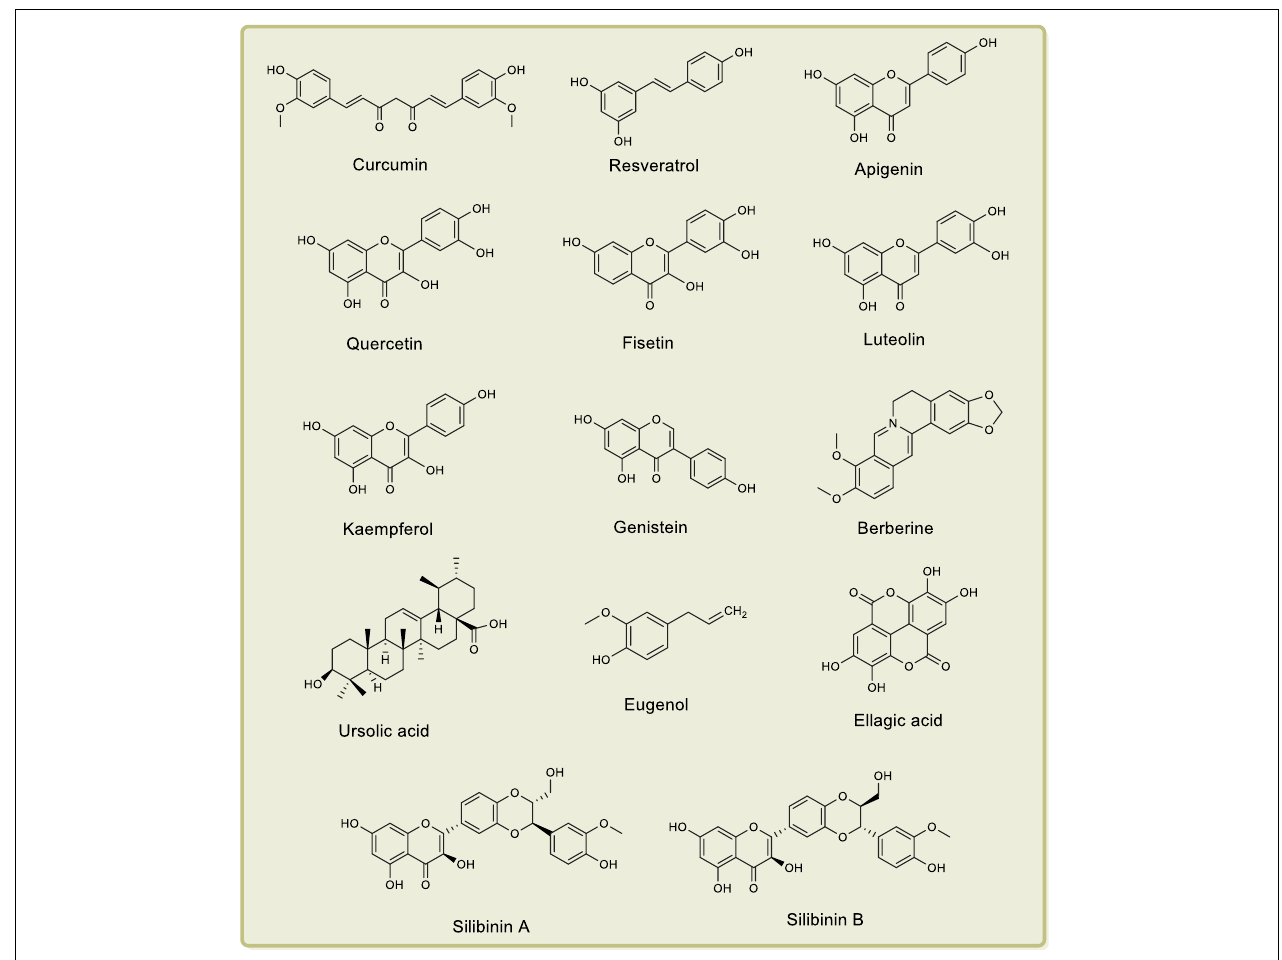
FIGURE 1 | Chemical structures of important anti-prostate cancer phytochemical compounds.